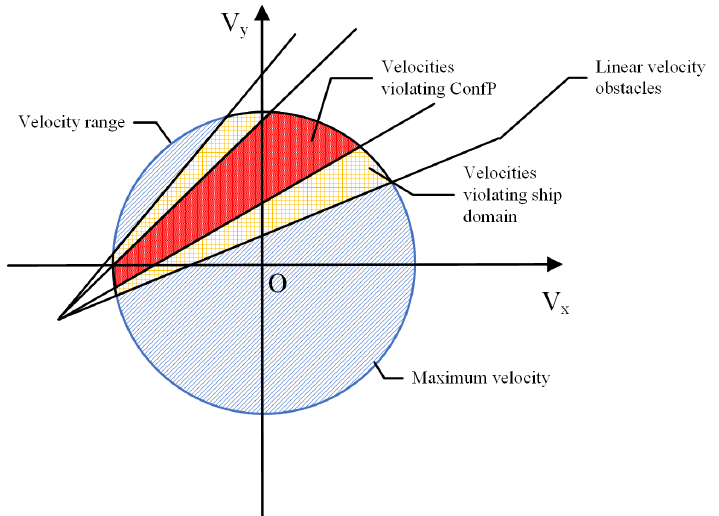
Figure 2. Illustration of TCR.